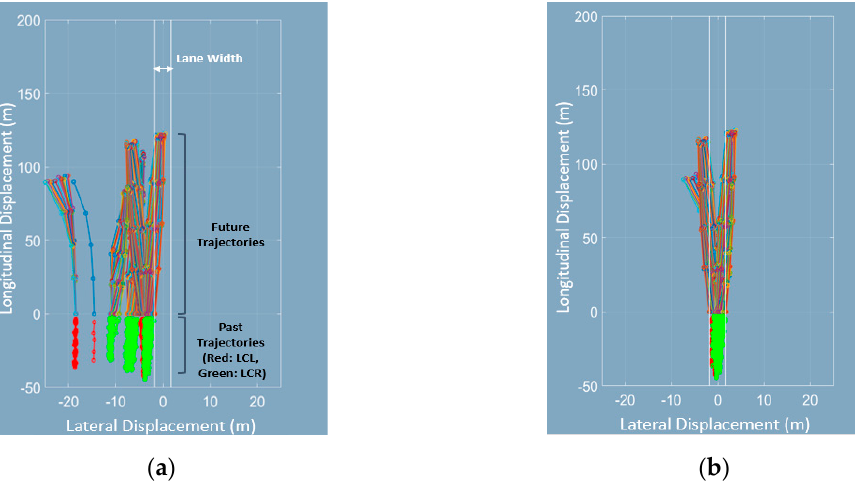
Figure 6. Results obtained after data processing and comparison of trajectories before and after lane assignment. For better visualization, in other words, we intend that one is not translated laterally, and another one is completely translated to the local curvilinear coordinate. ( a ) shows the trajectories transformed to the local curvilinear coordinates without lane assignment, whereas ( b ) shows the trajectories transformed to the local curvilinear coordinates with lane assignment.